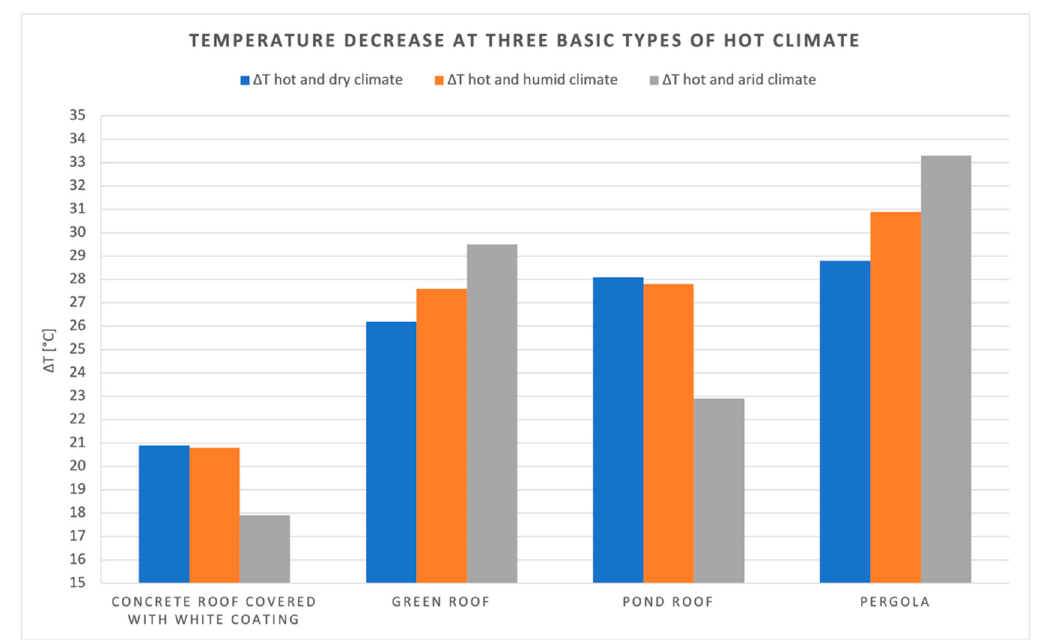
Figure 3 . Temperatures decrease in three basic types of hot climate: hot and dry in Athens, hot and humid in Mumbai and hot and arid in Riyadh, with measurements repeated over the course of three years, in July for Athens and Riyadh and in May for Mumbai .